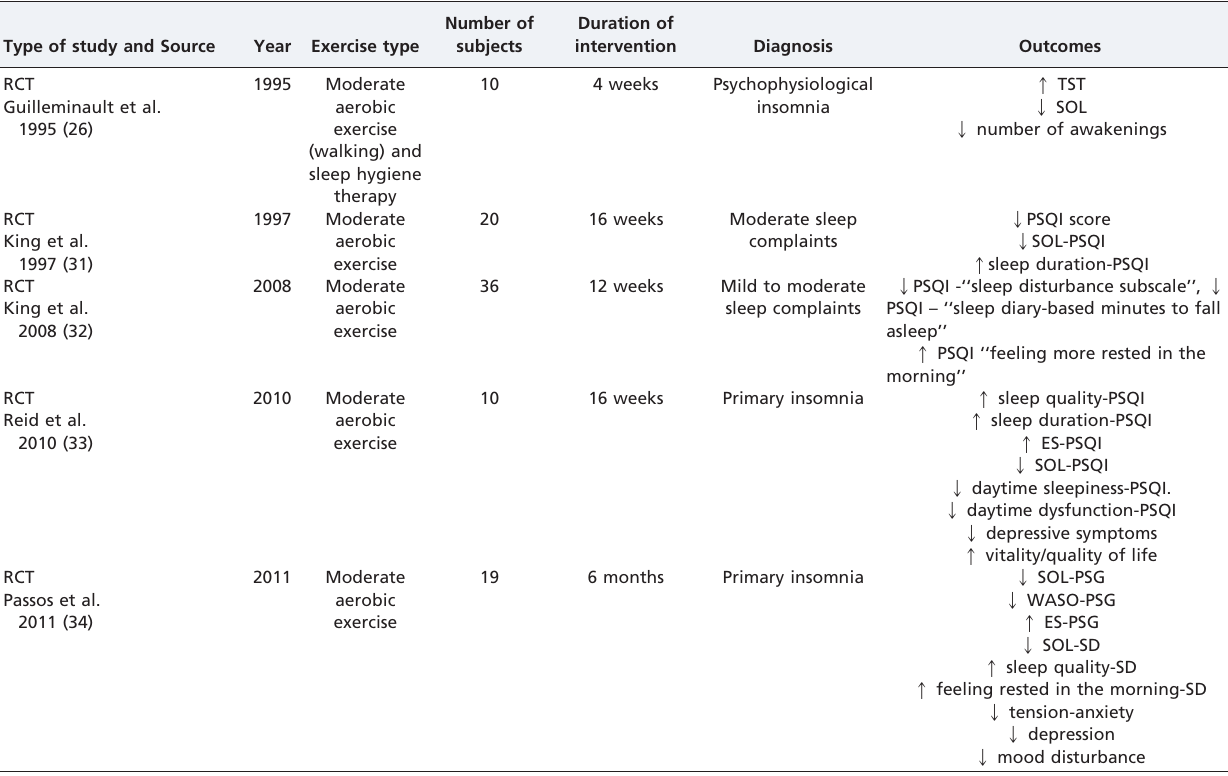
Table 1 - Characteristics of five studies about exercise training for chronic insomnia or sleep